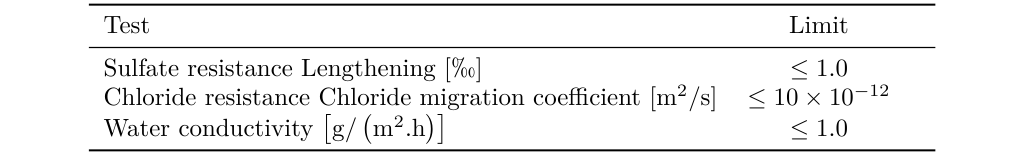
Table 1. Limits according to SIA 262/1 [2, 3].